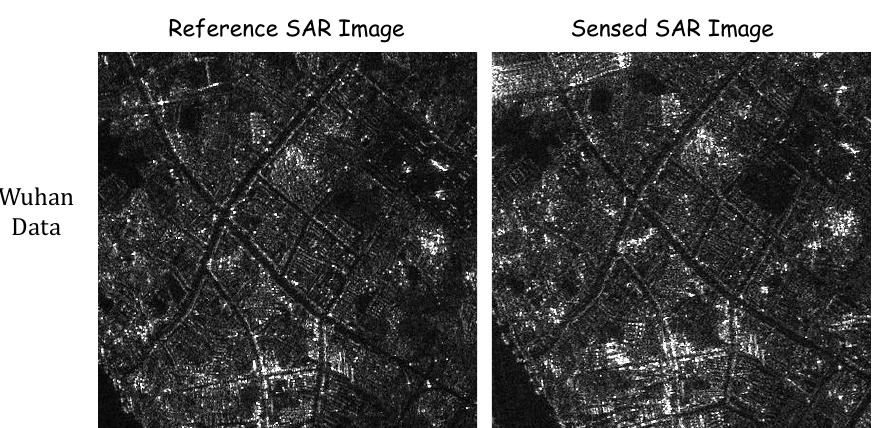
Figure 5. Reference and Sensed Images of Wuhan Data.